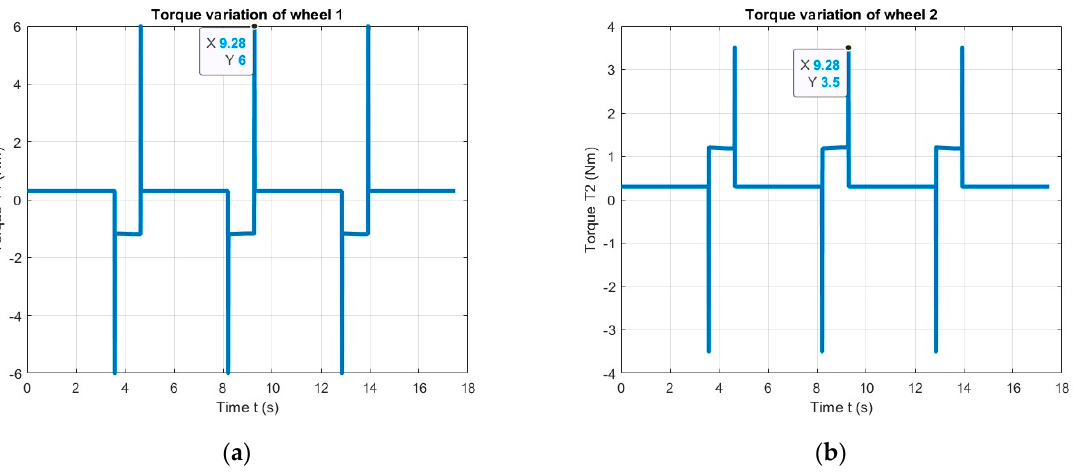
Figure 29. Torque variation for a 1 m square trajectory. ( a ) Wheel 1 (similar to wheel 3). ( b ) Wheel 2 (similar to wheel 4).